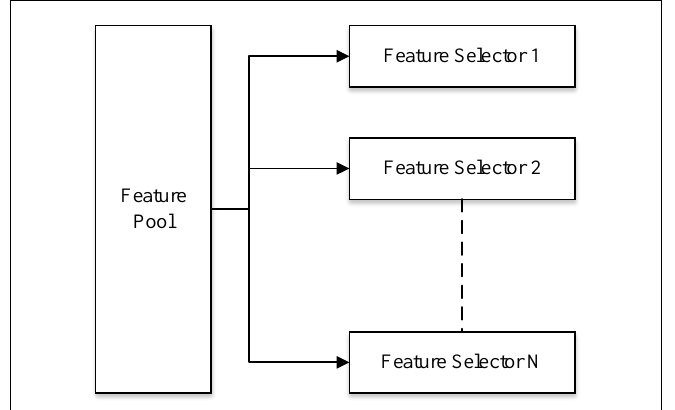
Figure 11. Feature selector.